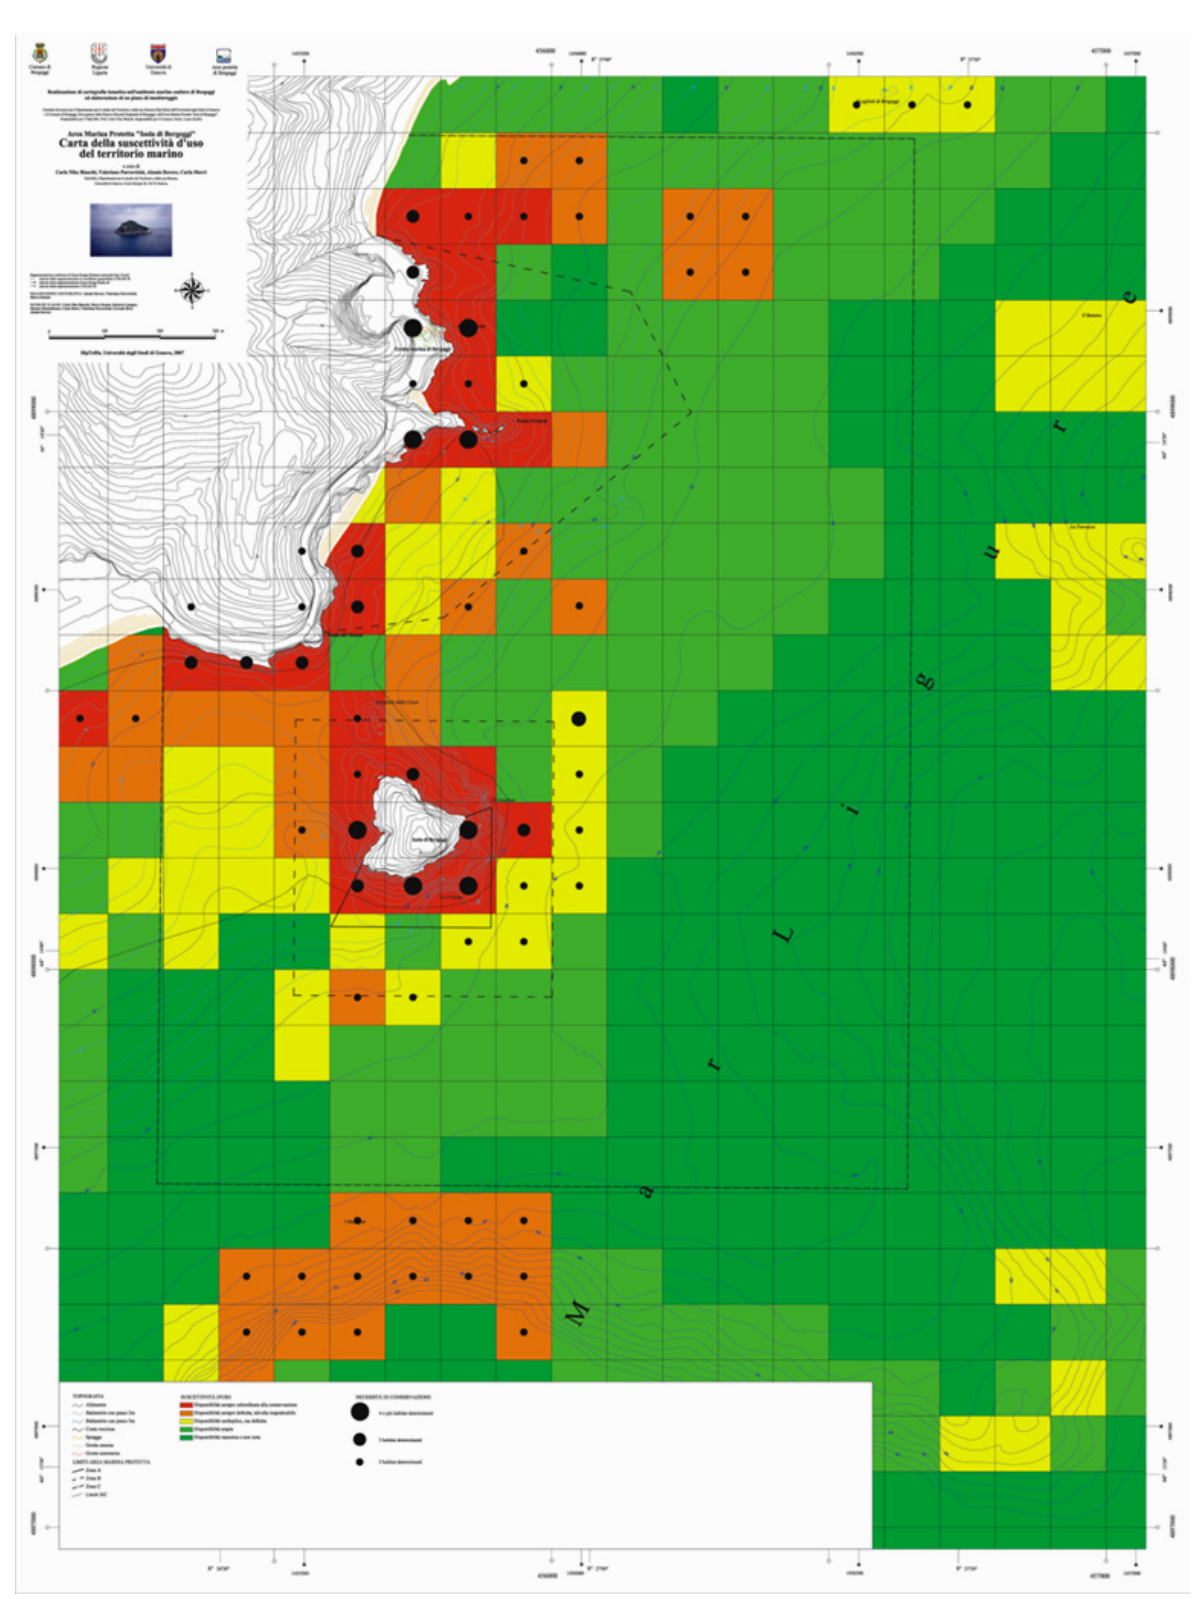
Figure 9. Reproduction at reduced scale of a map of the susceptibility to use of the marine territory. The example illustrates the MPA “Isola di Bergeggi” (original scale 1:2,000). This and similar maps can be freely downloaded, at their full size, from the SEAMap site